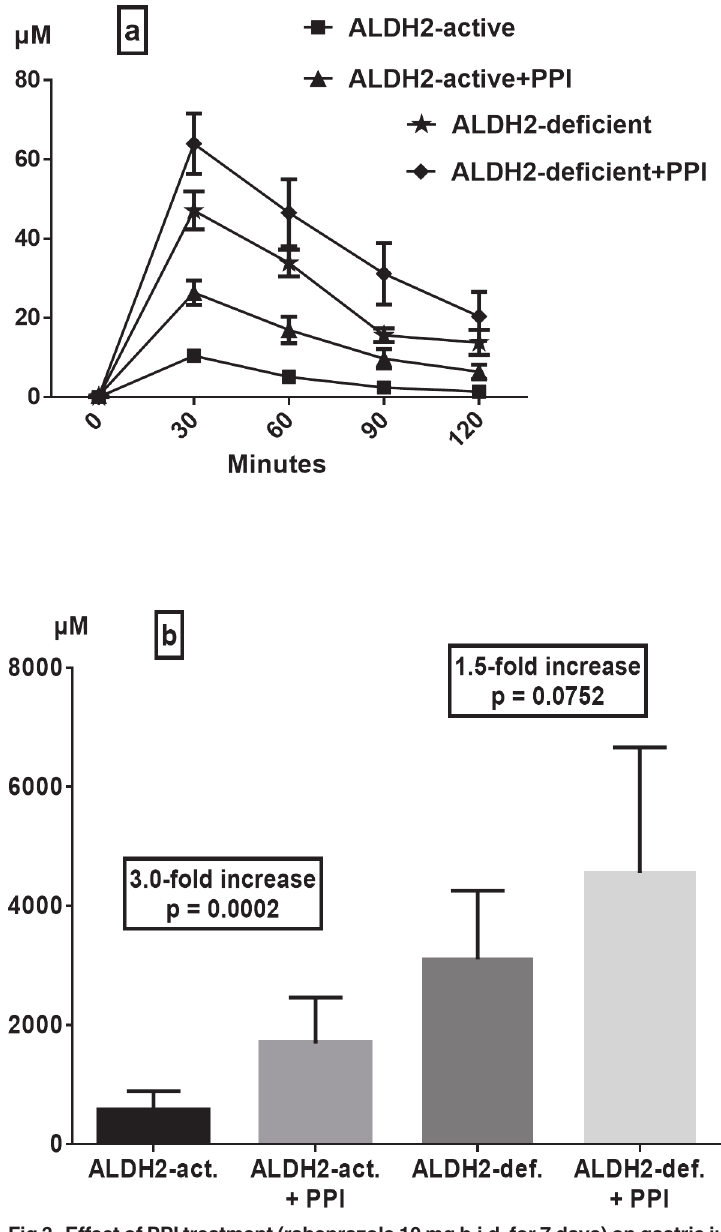
Fig 3. Effect of PPI treatment (rabeprazole 10 mg b.i.d. for 7 days) on gastric juice acetaldehyde levels (a) and areas under the curve (b) after intragastric infusion of ethanol (15 vol%, 0.5 g/kg) in ALDH2- active and -deficient subjects (means ±